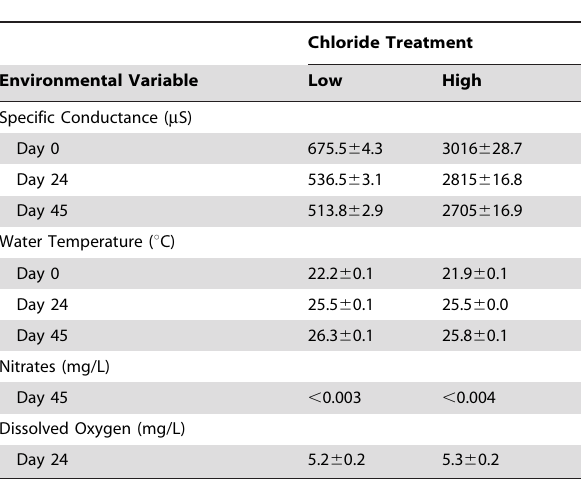
Table 2. Mean abiotic environmental variables measured in all mesocosms (n=20 per chloride treatment) from study days 0–47 6 standard